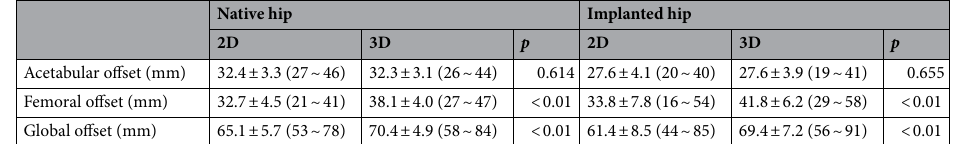
Table 2. Comparison between 2 and 3D methods for acetabular offset, femoral offset, and global offset.